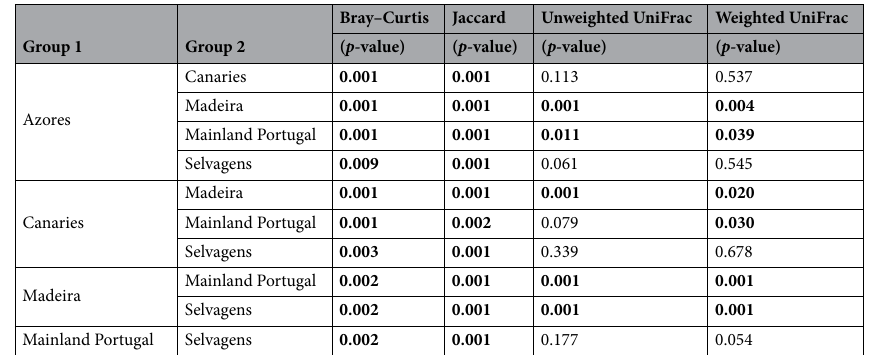
Table 1. PERMANOVA pairwise comparisons for β diversity indices based on abundance (Bray–Curtis), presence or absence of microbiome species (Jaccard), sequence distance (Unweighted UniFrac), and sequence distance including abundance (Weighted UniFrac). Significant p -values in